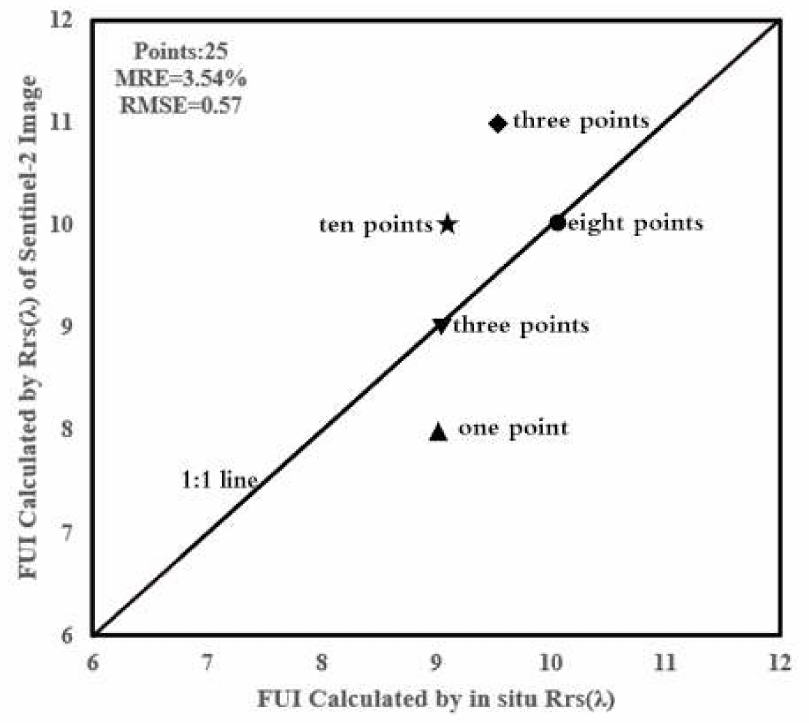
Figure 5. Scatterplots showing the derivation accuracies of FUI from the remote-sensing reflectance of the Sentinel-2 image compared with the in situ remote-sensing reflectance; the number represents the number of